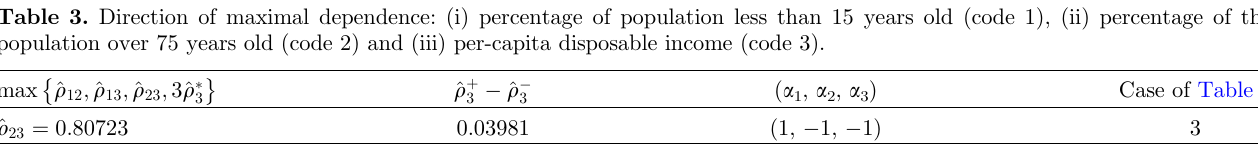
Table 3. Direction of maximal dependence: (i) percentage of population less than 15 years old (code 1), (ii) percentage of the